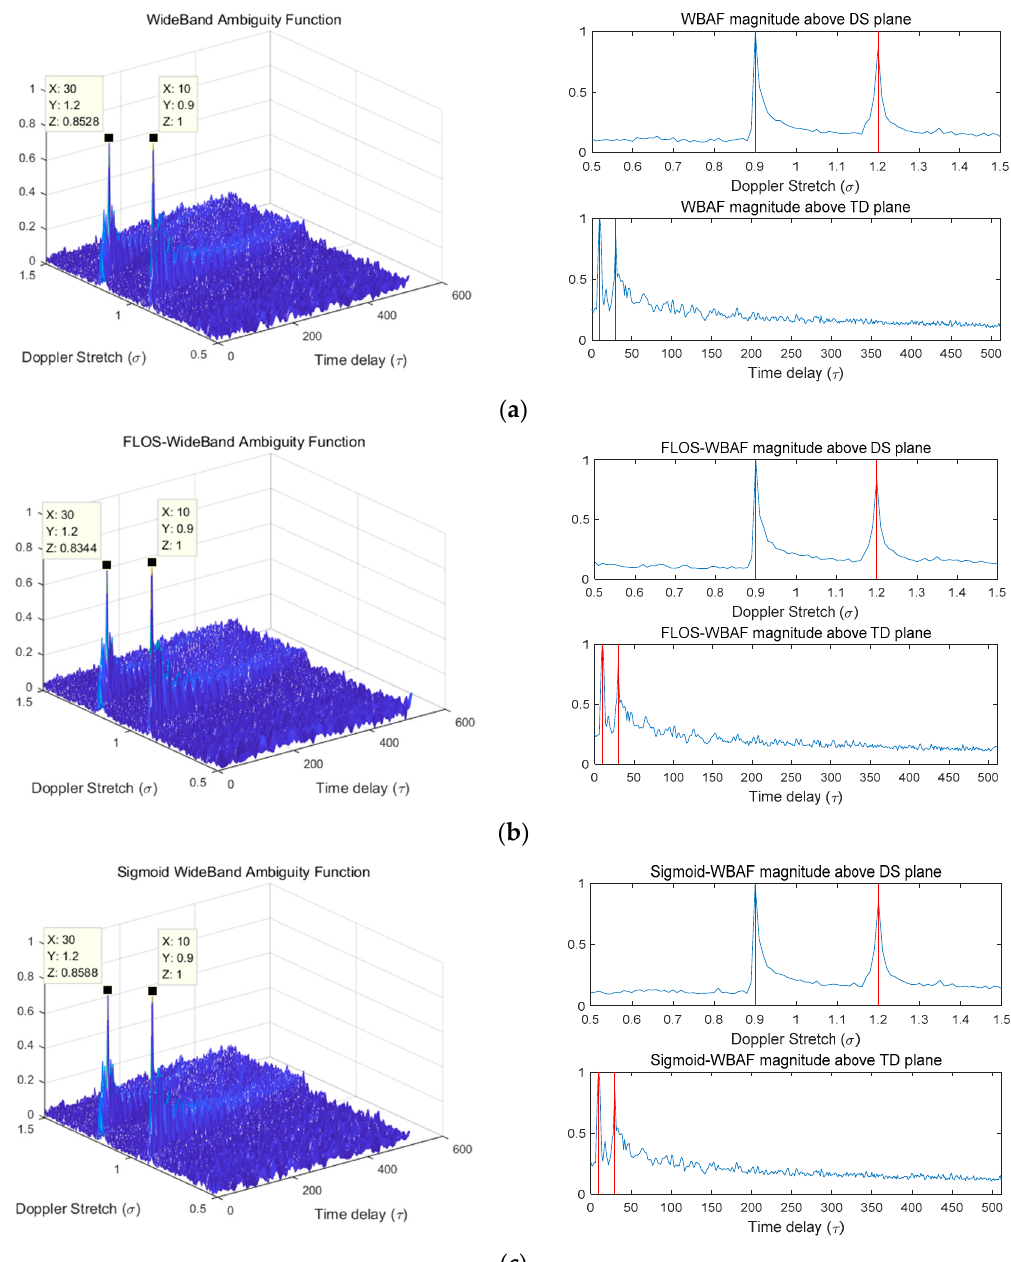
Figure 3. The normalized spectra of WBAF, FLOS-WBAF, and Sigmoid-WBAF for Gaussian noise with SNR = − 10 dB. ( a ) The three-dimensional (3D) plot of WBAF and its Doppler stretch (DS) and time delay (TD) section planes; ( b ) the 3D plot of FLOS-WBAF with p = 1.1 and its DS and TD section planes; ( c ) the 3-D plot of Sigmoid-WBAF and its DS and TD section planes.